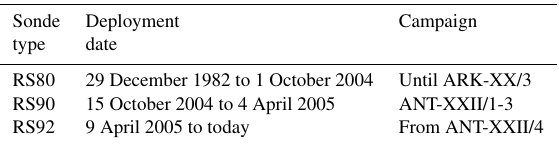
Table 1. Overview of the radiosonde types on board PO- LARSTERN